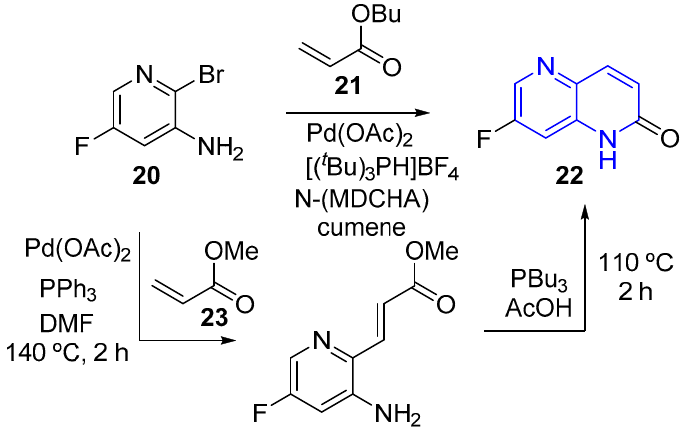
Scheme 6. Conrad-Limpach reaction with Meldrum’s acid for the preparation of 1,5-